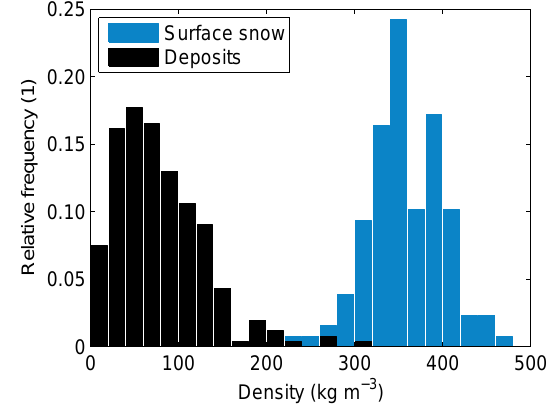
Fig. 2. Relative frequency distribution of the measured density of solid deposits (254 measurements, March 2005–March 2009) and surface snow down to a depth of 10cm (128